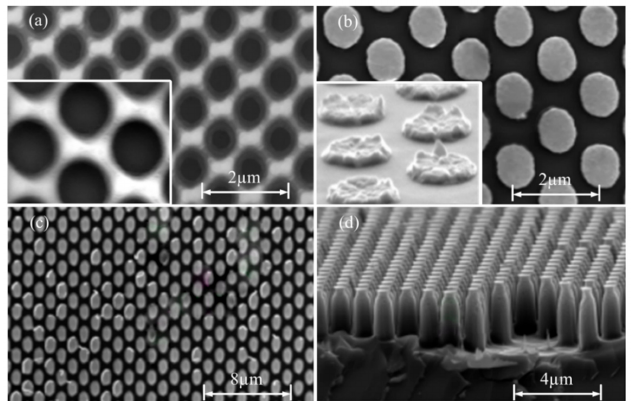
Figure 7. SEM images of ( a ) laser interference lithography of photoresist mask pattern; ( b ) Au coating deposited onto the lithography template before ICP etching; ( c ) top view and ( d ) side view of the moth-eye structure with a waist on intrinsic silicon